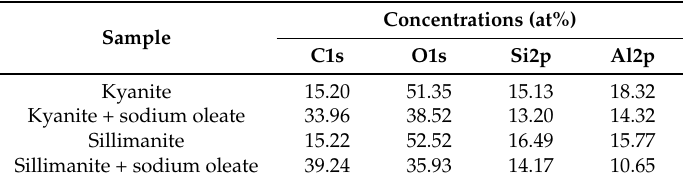
Table 3. XPS-derived surface concentrations (atomic % normalized to Al, O, Si and C) on kyanite and